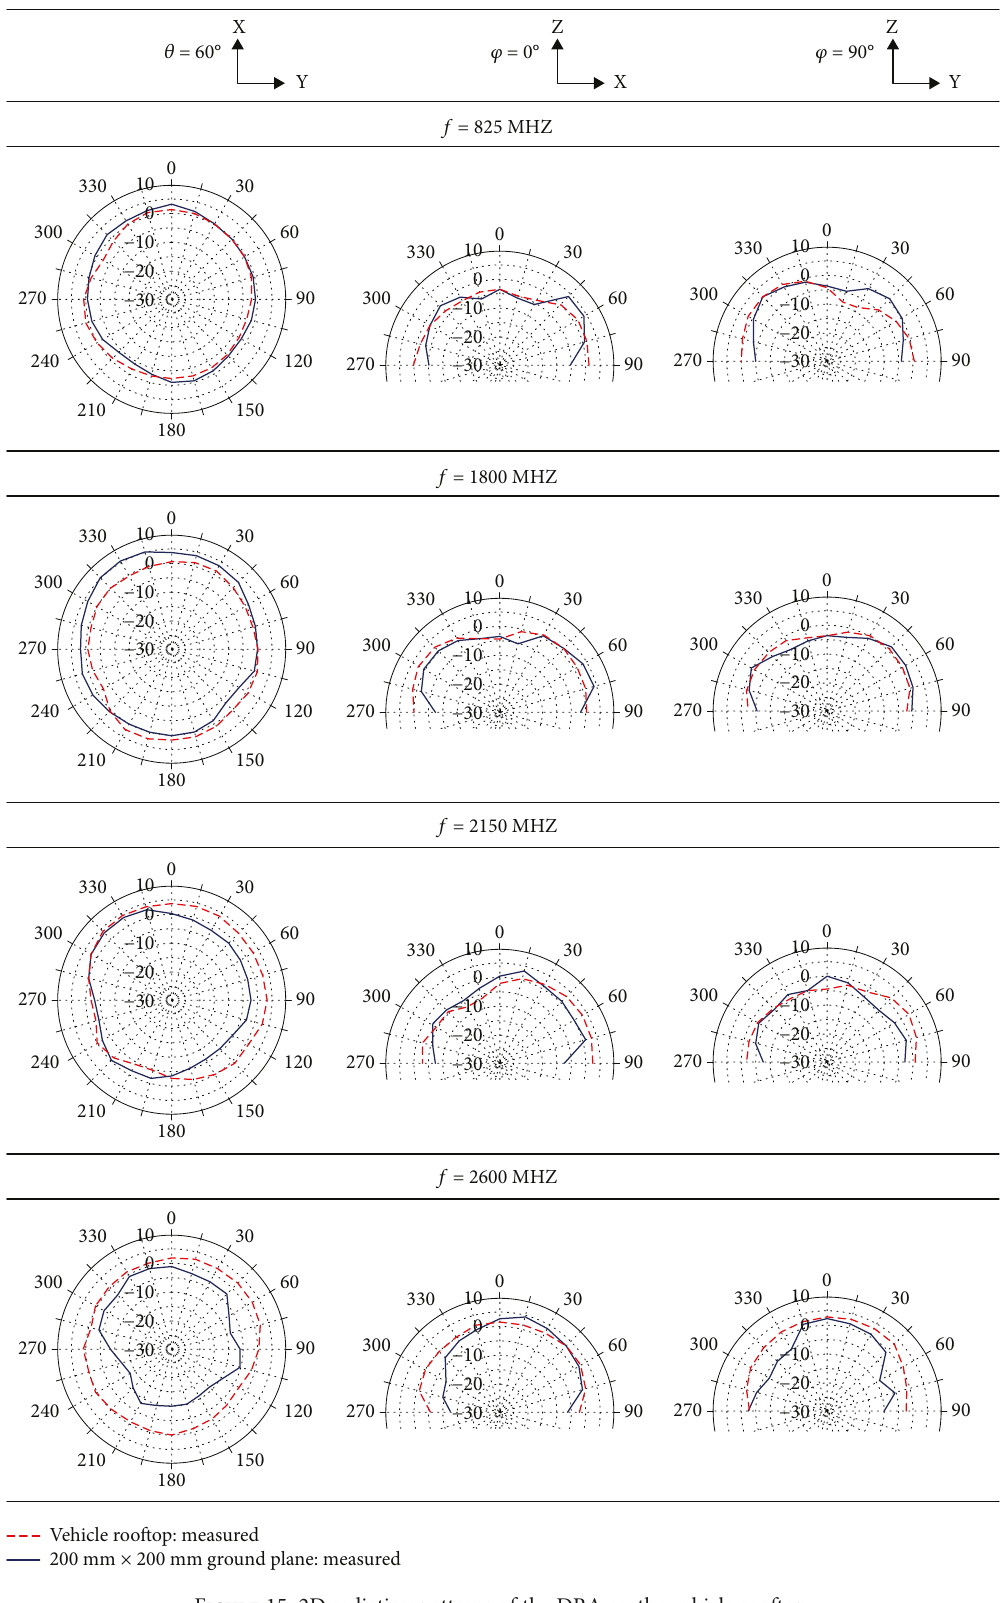
Figure 15: 2D radiation patterns of the DRA on the vehicle